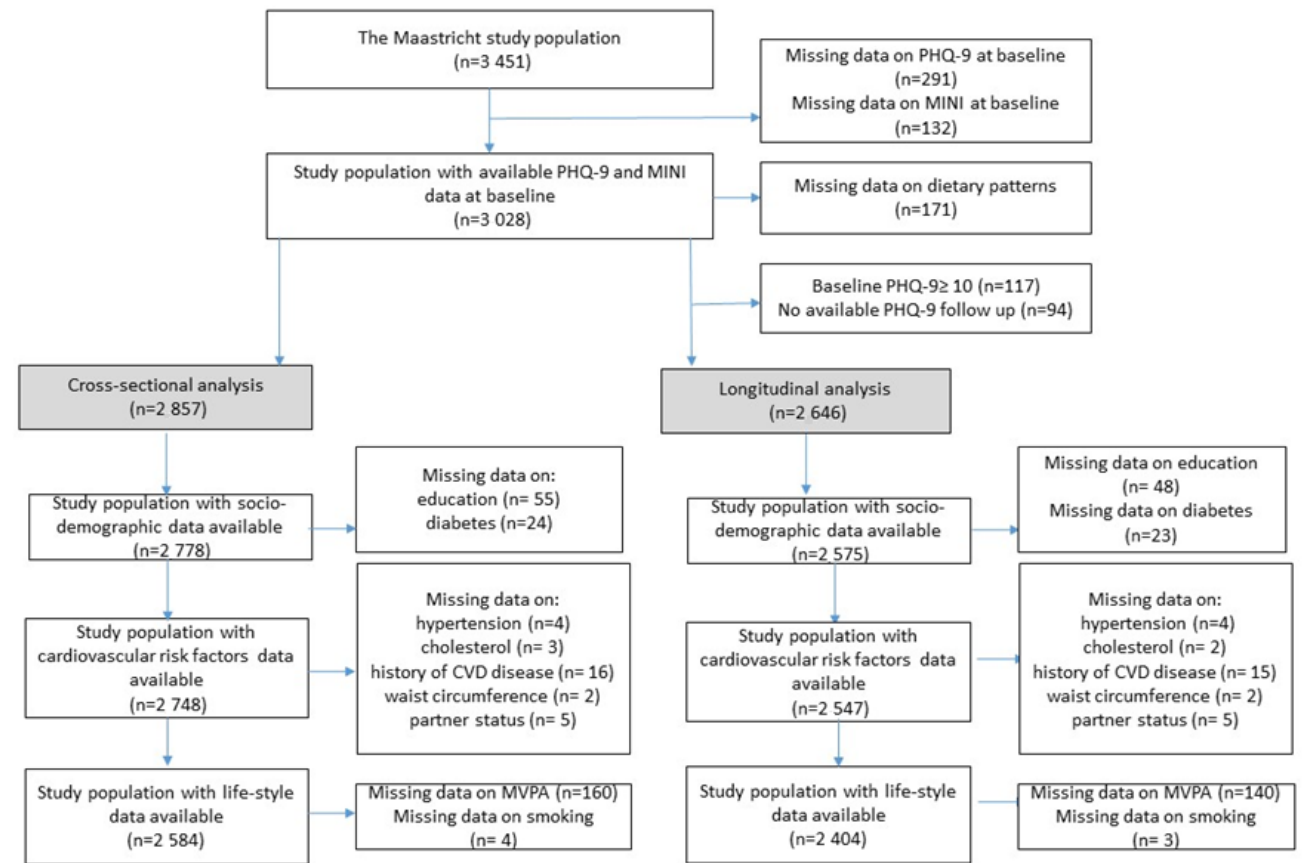
Figure 1. Flowchart of the study population. MINI: Mini-International Neuropsychiatric Interview; PHQ-9: 9-item Patient Health Questionnaire; CVD: Cardiovascular diseases; MVPA: Moderate-to-vigorous Physical